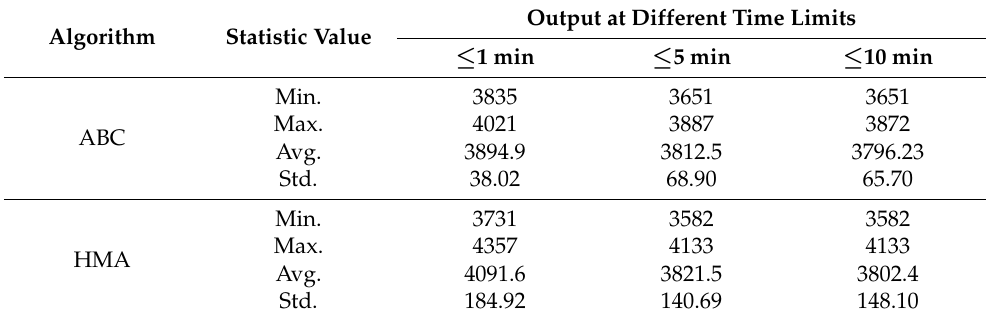
Table 3. Statistics of the total cost of the globally best solution of the HMA and the ABC algorithms on the “egl-e1-A” instance, within different time